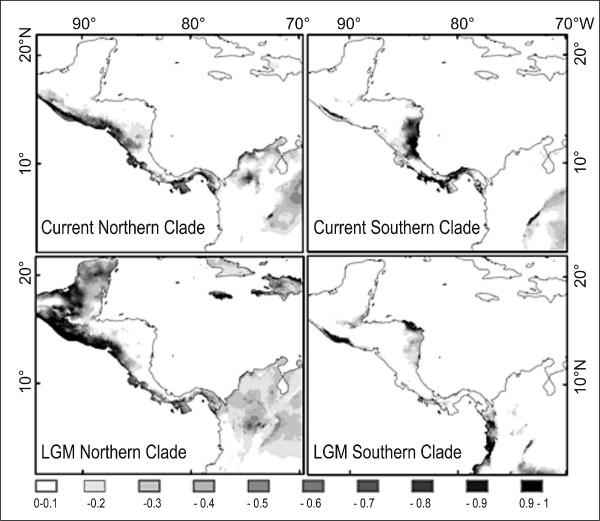
Niche modeling. Results for ecological niche modeling depicting predicted habitat suitability for túngara frogs in Middle America. Higher values indicate higher habitat suitability. "LGM" models are predictions for the Last Glacial Maximum (~21,000 years ago) based on paleoclimate models. See text for details.